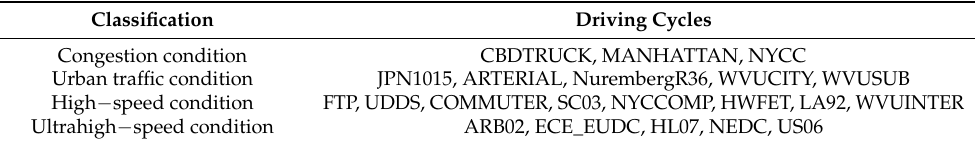
Table 2. Categories of 21 driving cycles and similar conditions.